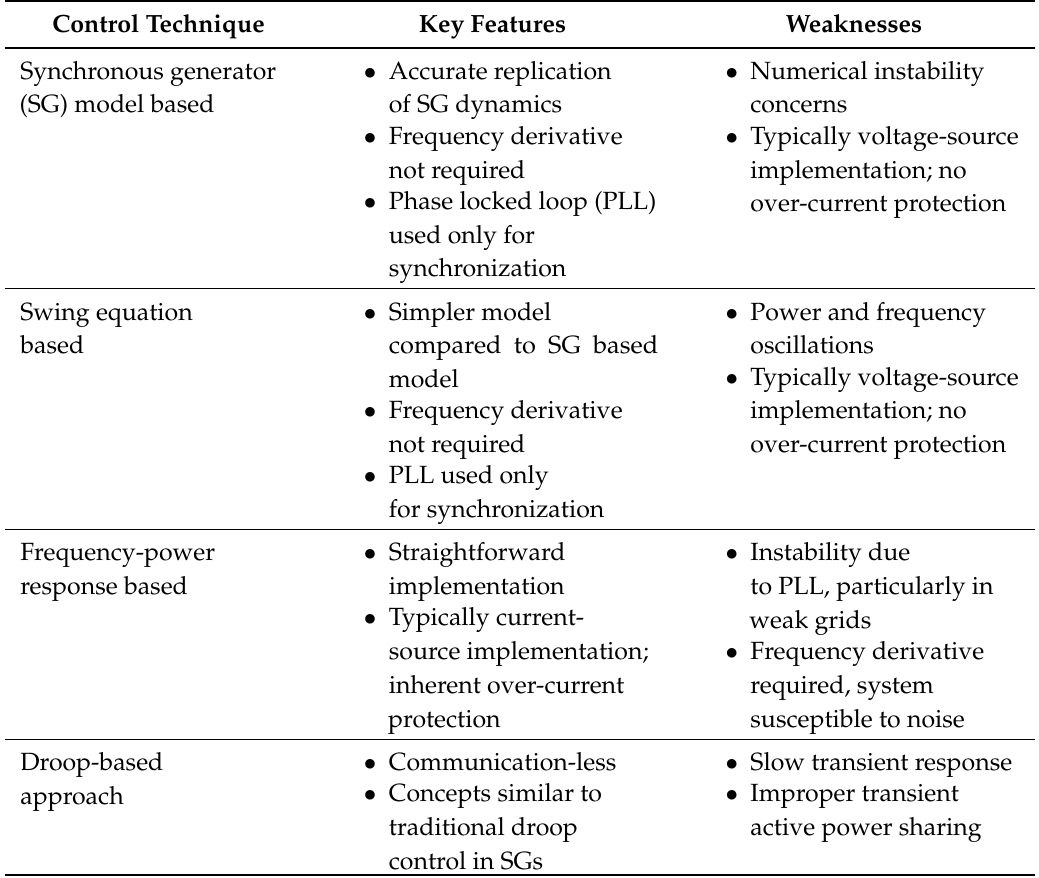
Table 1. Summary of Virtual Inertia Control